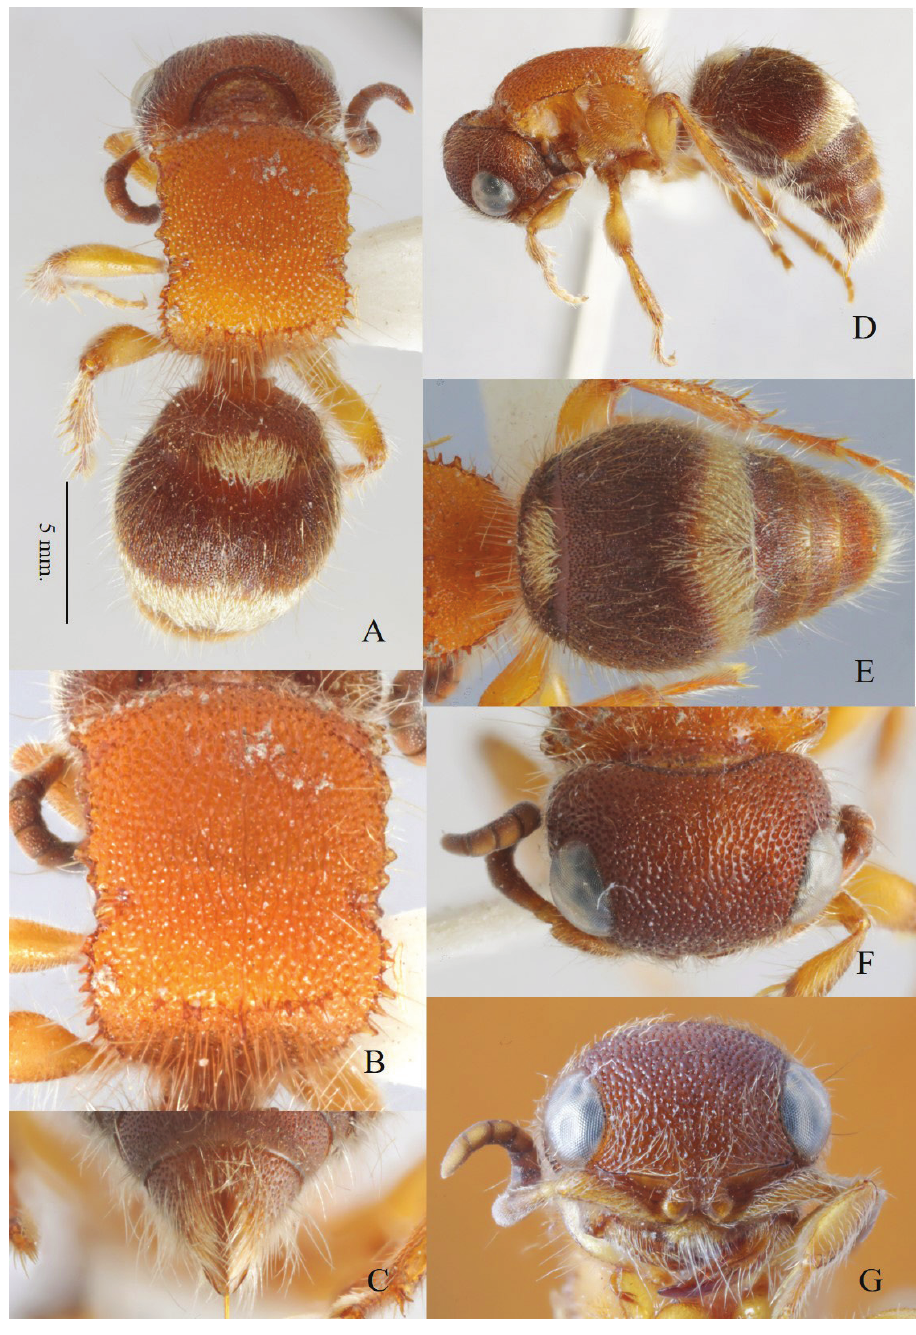
Figure 2. Bischoffitilla selangorensis , ♀ , Thailand A dorsal view B mesosoma dorsum C pygidium D lateral view E metasomal terga F vertex G frons and